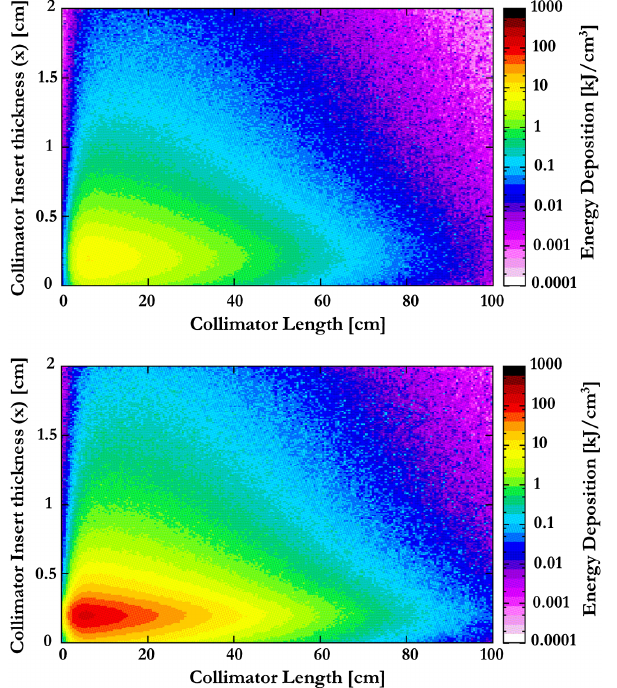
FIG. 14. Energy deposition (kJ = cm 3 ) cuts at the maximum temperature on the tungsten inserts in longitudinal section, as calculated by FLUKA for Test 1 (top) and Test 3 (bottom) at the end of the impact.